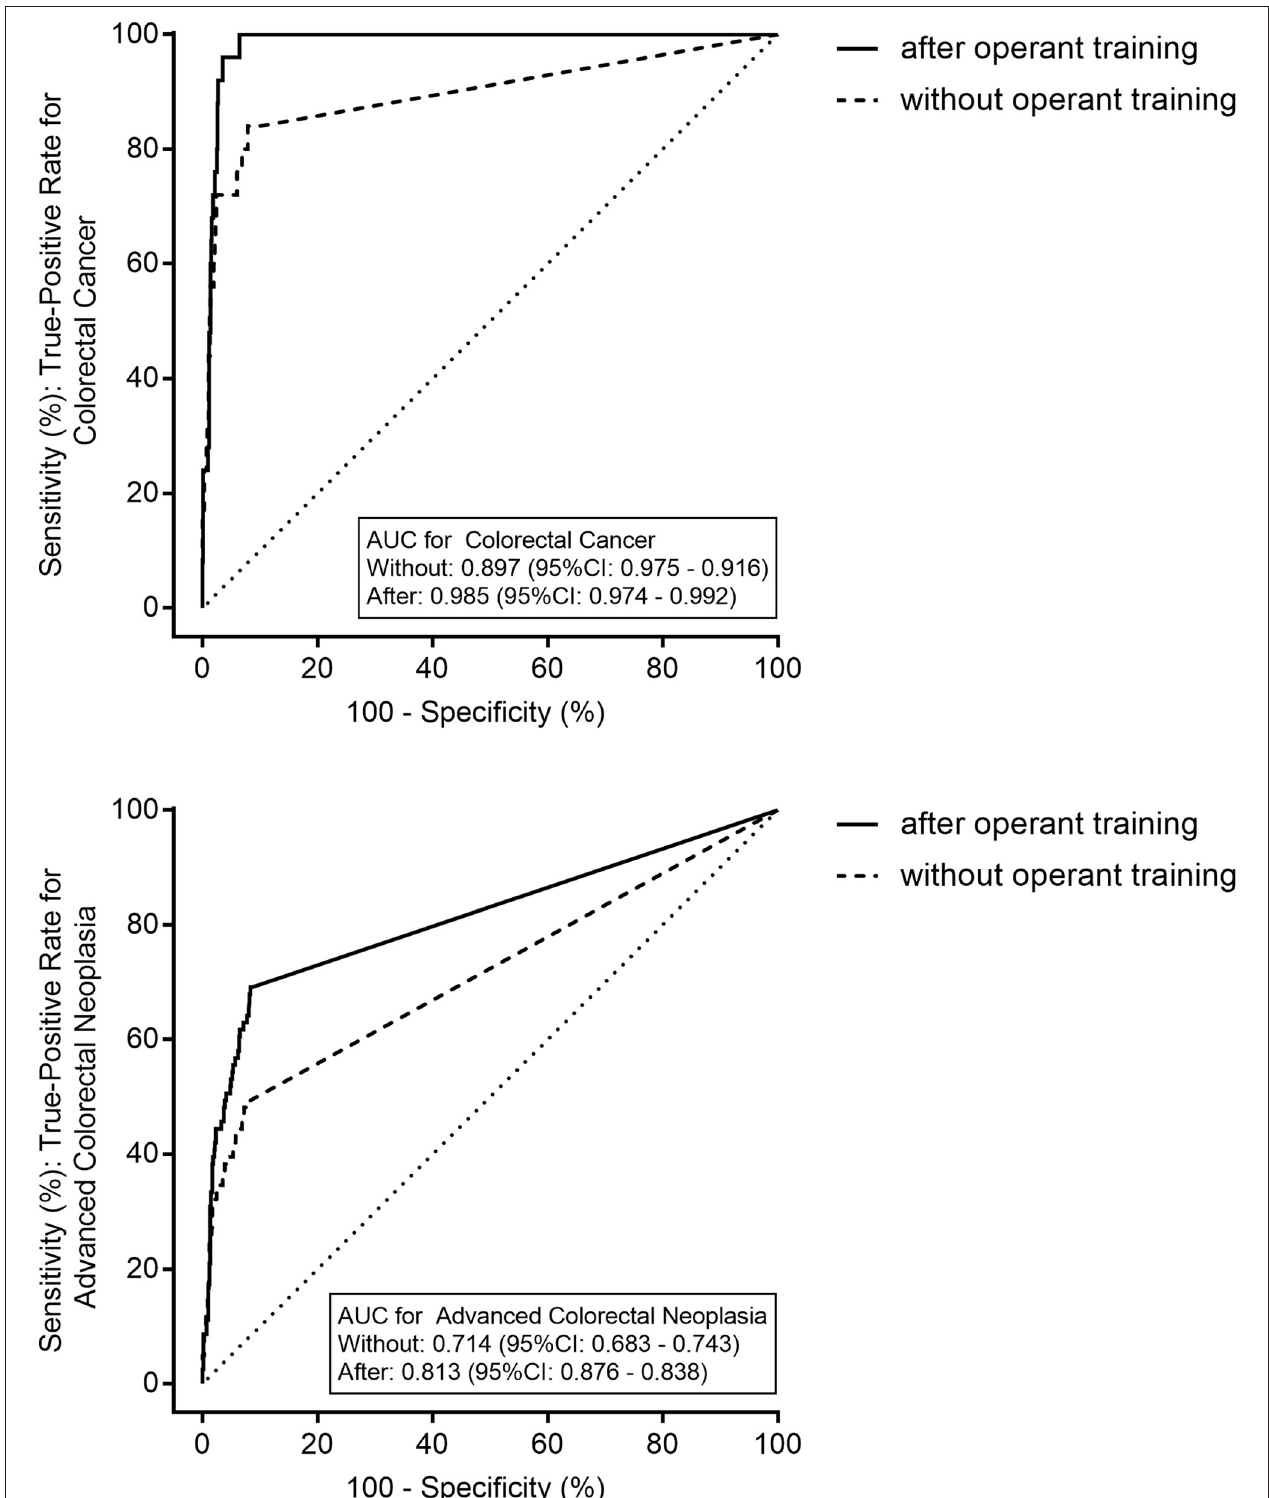
FIGURE 2 | The receiver operating characteristics curves of the quantitative fecal immunochemical test (qFIT) without and after the practical sample collection operant training for colorectal cancer (CRC) and advanced colorectal neoplasia. AUC, the area under the curve.